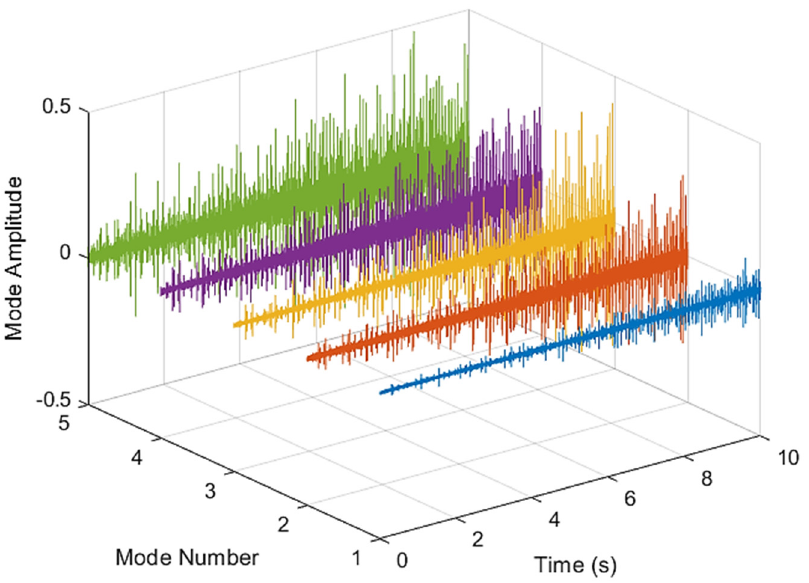
Figure 11. VMD analysis from a combined fault bearing under increasing rotational speed condition in time domain.